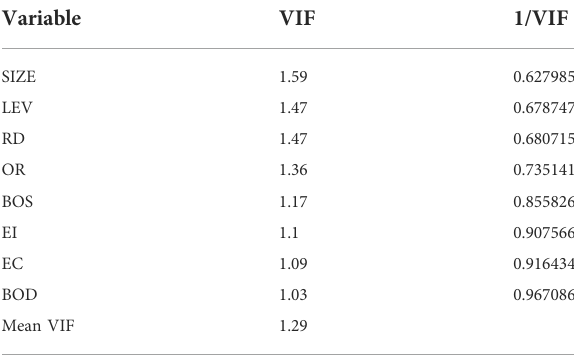
TABLE 3 Variance in fl ation factor (VIF)